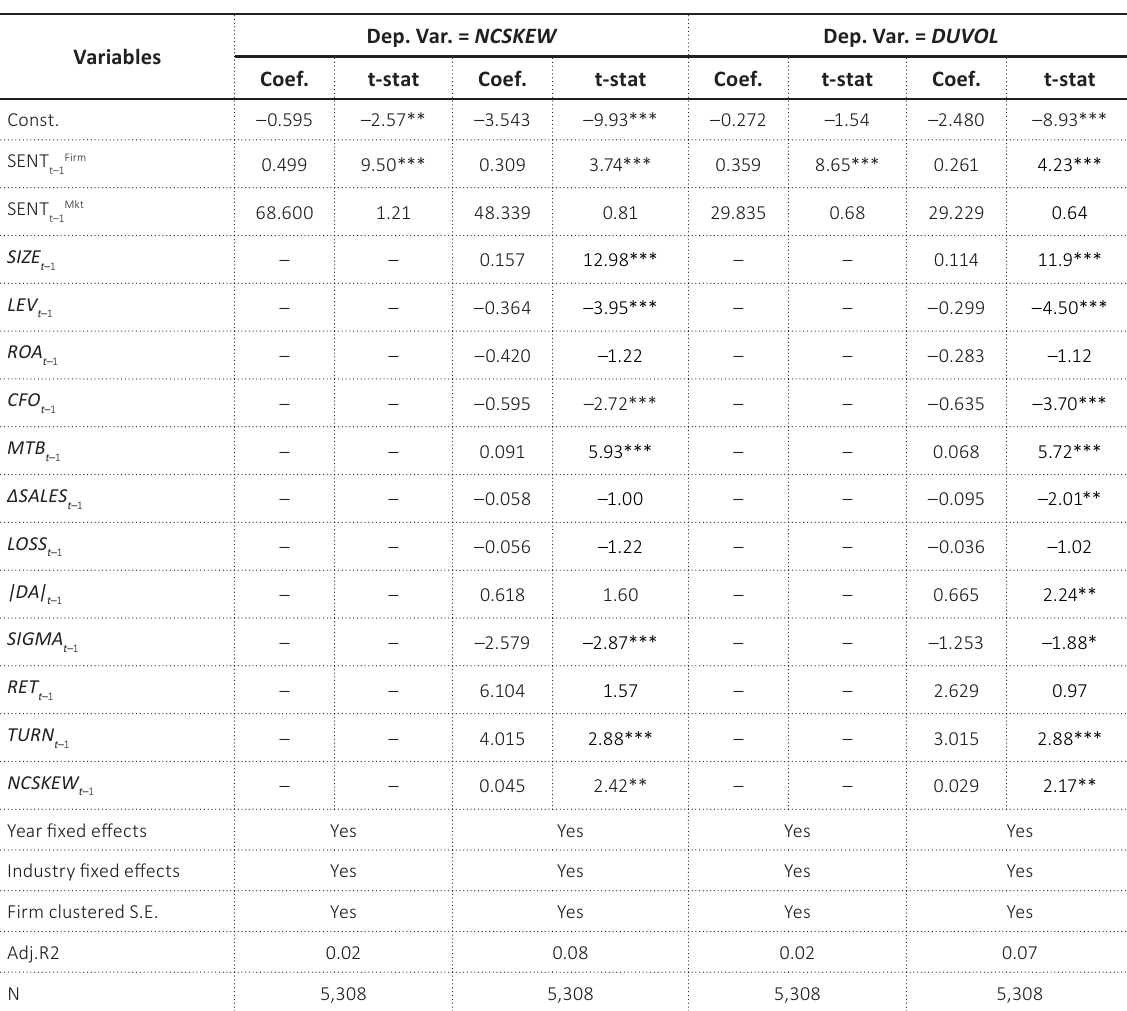
Table B2. The effect of firm-specific investor sentiment on stock price crash